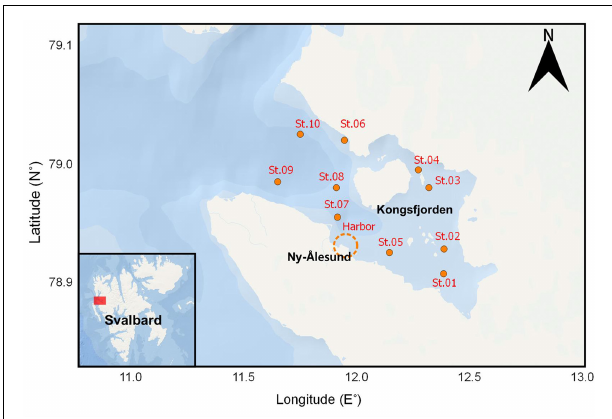
FIGURE 1 | Sampling sites of this study.